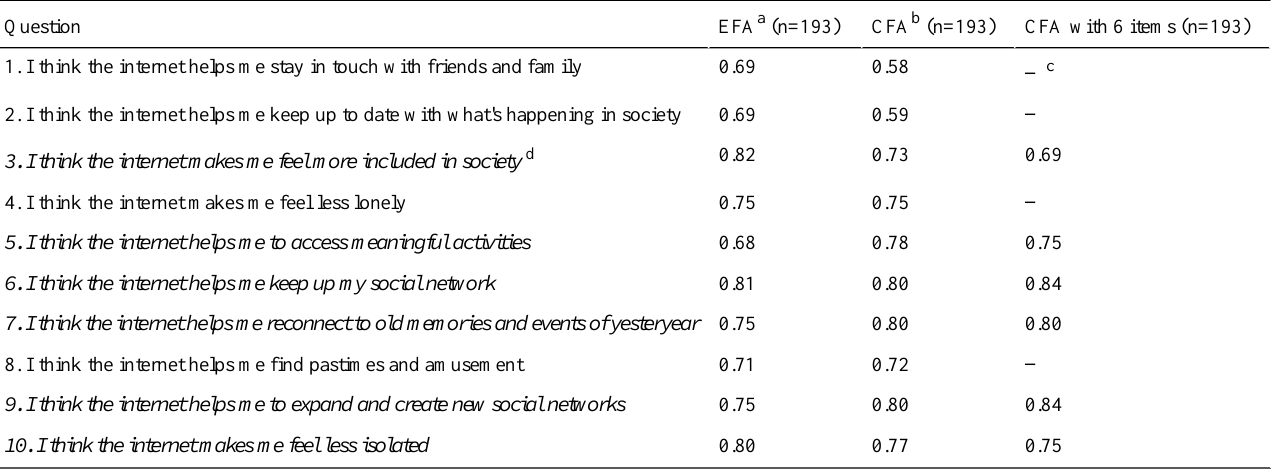
Table 3. Standardized factor loadings from exploratory and confirmatory factor analyses for the 1-factor solution based on the original 10 questionnaire items and the chosen 6 items after exclusions. Based on the 2 different parts of the data: sampled (EFA) and nonsampled (CFA)